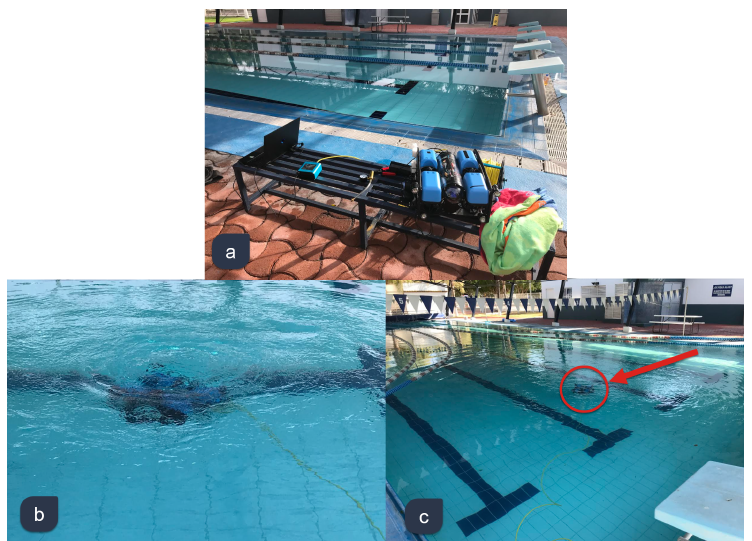
Figure 4. Experimental set-up at Tecnologico de Monterrey, Campus Querétaro. ( a ) Ground control station at a side of the semi-Olympic pool. ( b ) BlueROV2 deployed into the water. ( c ) Autonomous trajectory tracking